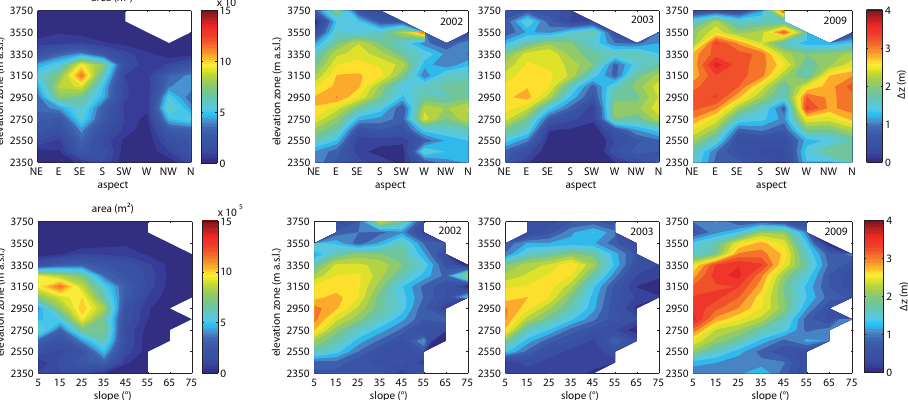
Fig. 4. Contour plots of the elevation distribution of area and surface elevation changes ( 1z ) dependent on aspect and slope. In the first column the area distribution is shown. Panels 2, 3 and 4 in the first row present 1z dependent on aspect for the accumulation seasons 2002, 2003 and 2009. In the second row the area and 1z dependent on slope are shown, respectively.